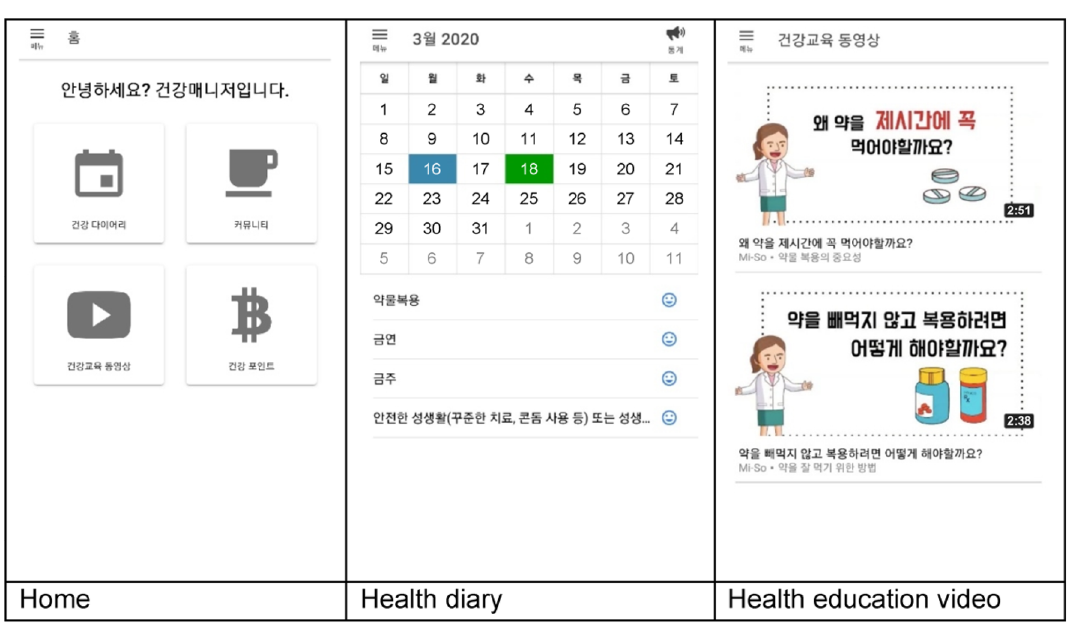
Figure 2. Screenshots of the mobile application’s main